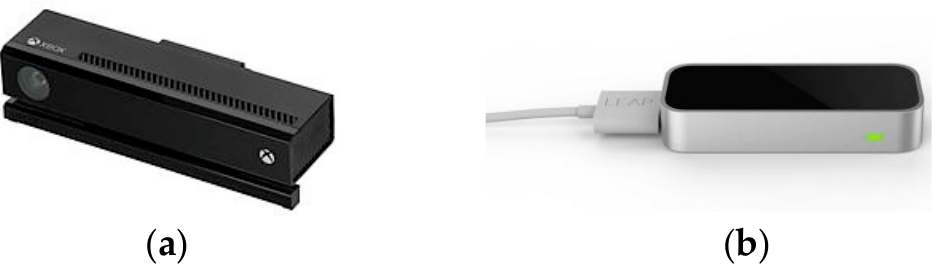
Figure 5. Commercial vision-based devices for gesture recognition: ( a ) Kinect [135]; ( b ) Leap Motion [136].